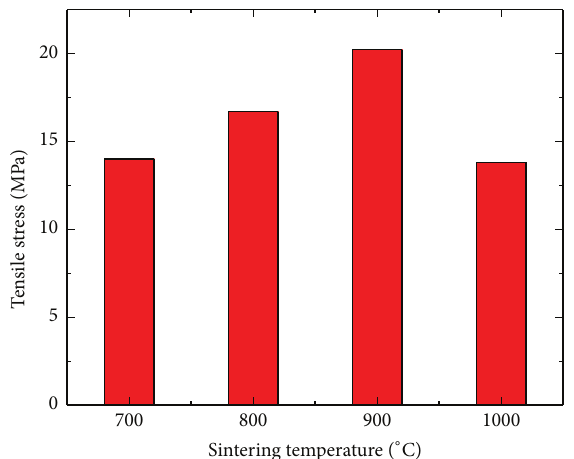
Figure 10: Tensile strength of the oriented linear porous metal with different sintering